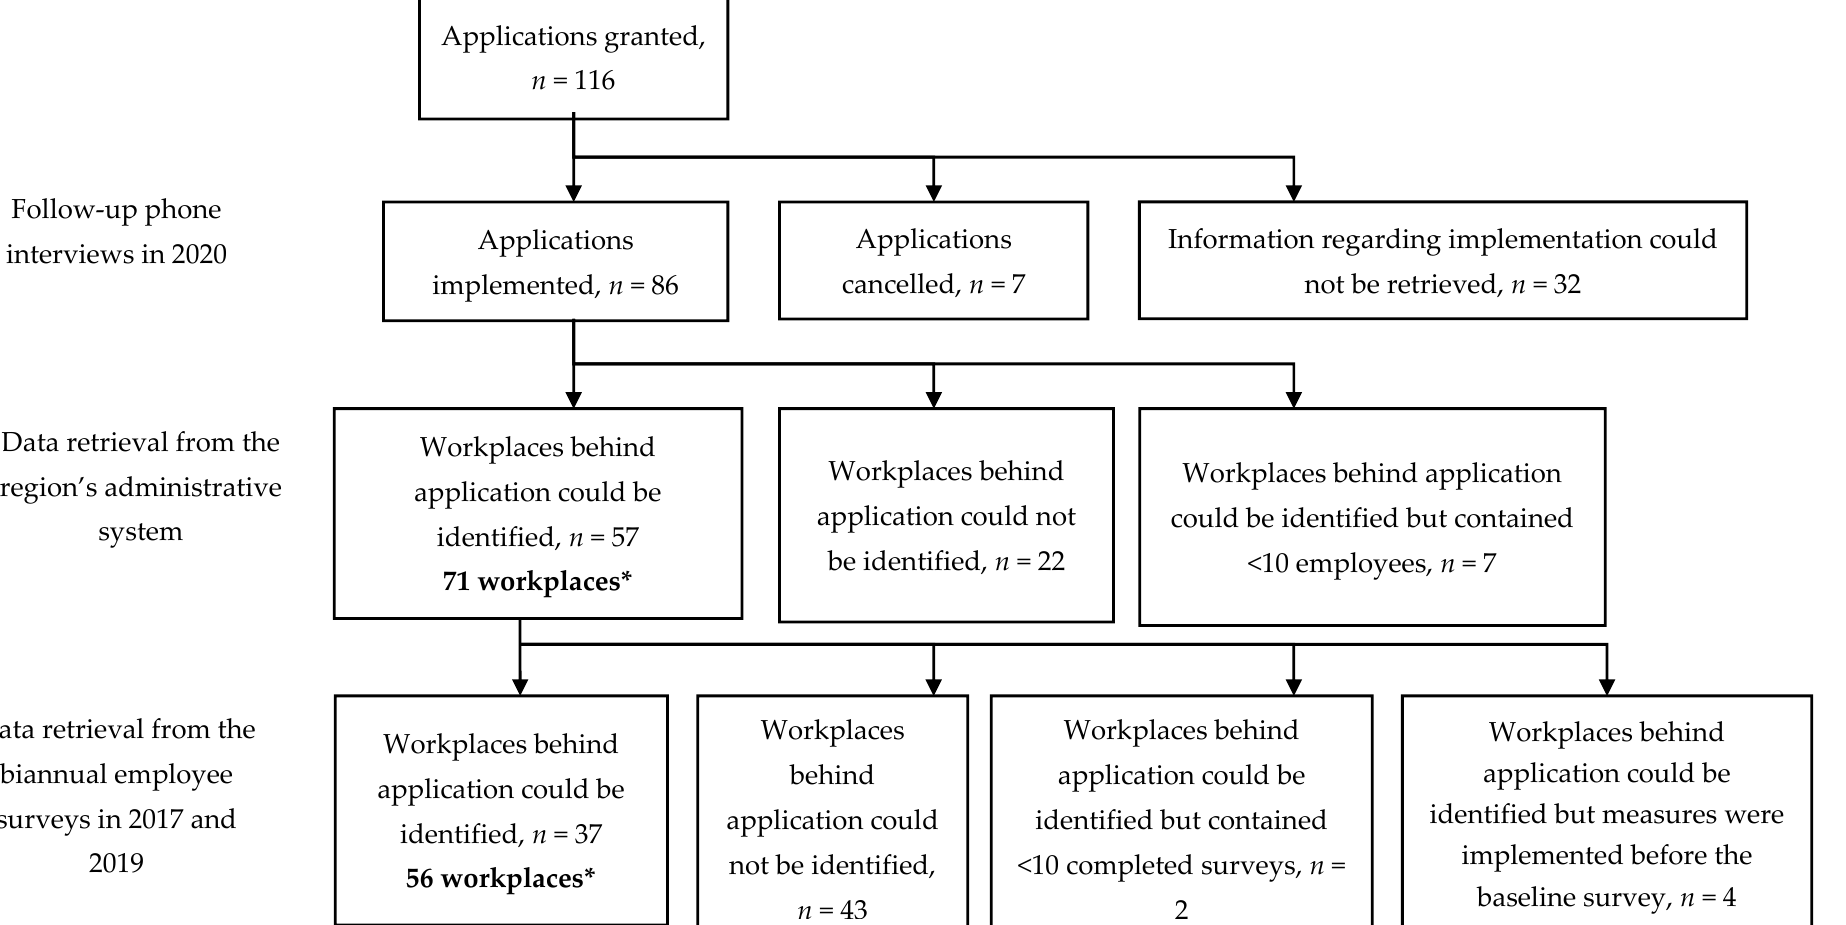
Figure 1. Flowchart describing the number of granted and implemented applications in the intervention together with the number of workplaces (i.e., intervention groups) identified and eligible for the evaluation of intervention effects. * Applications could contain more than one measure; therefore, applications (and measures) could involve more than one workplace and workplaces could be part of more than one application.